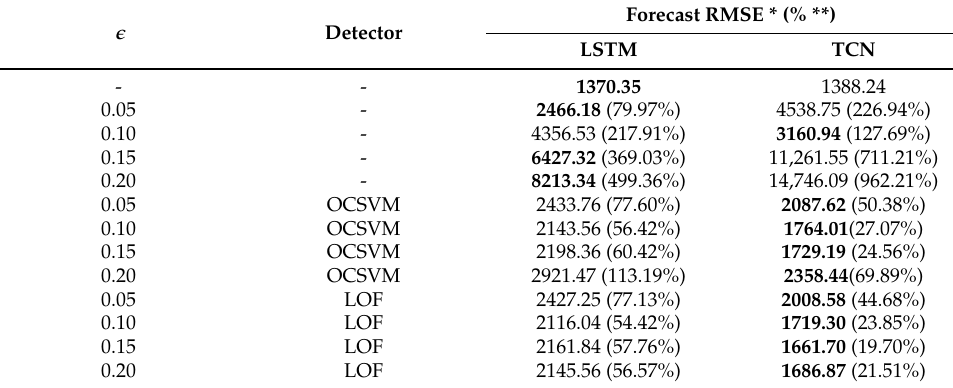
Table 3. Comparison among RMSE obtained with different forecasting models and detectors. The lowest RMSE for each combination of epsilon/detector was highlighted in bold.